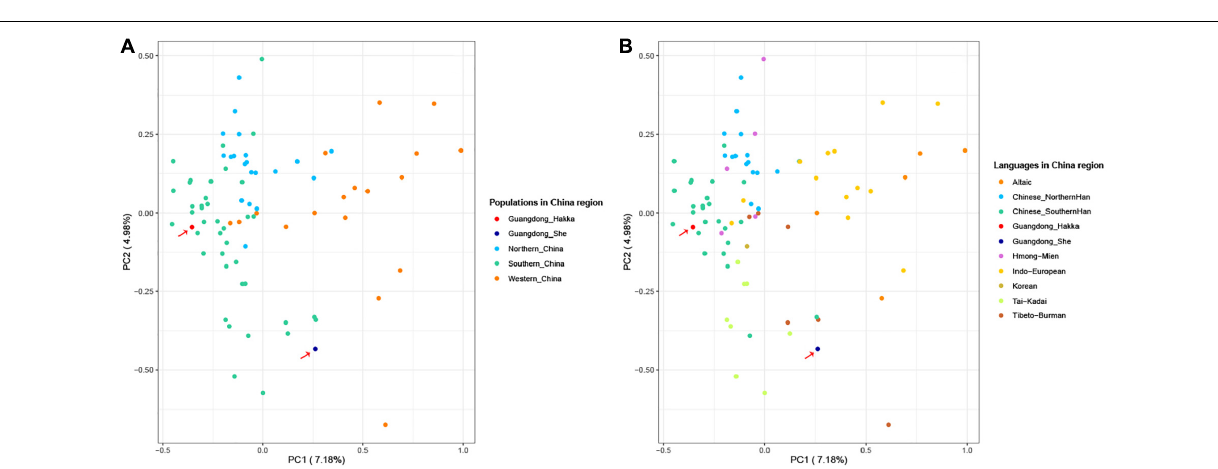
FIGURE 3 | Principal component analysis (PCA) based on the 23 Y-STRs frequency profiles among Guangdong Hakka, Guangdong She, and 83 Chinese populations. (A) PCA from geographical scale. (B) PCA from linguistic